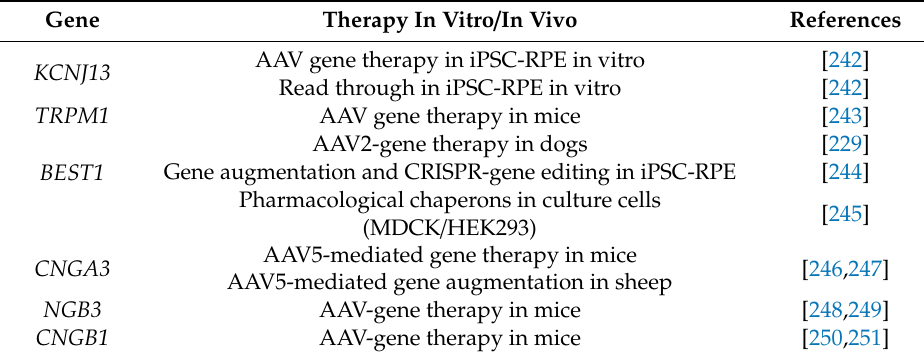
Figure 7. Potential therapies for ocular channelopathies caused by gene mutations. Table 2. Therapies for ion channelopathies in practice and clinical trials.